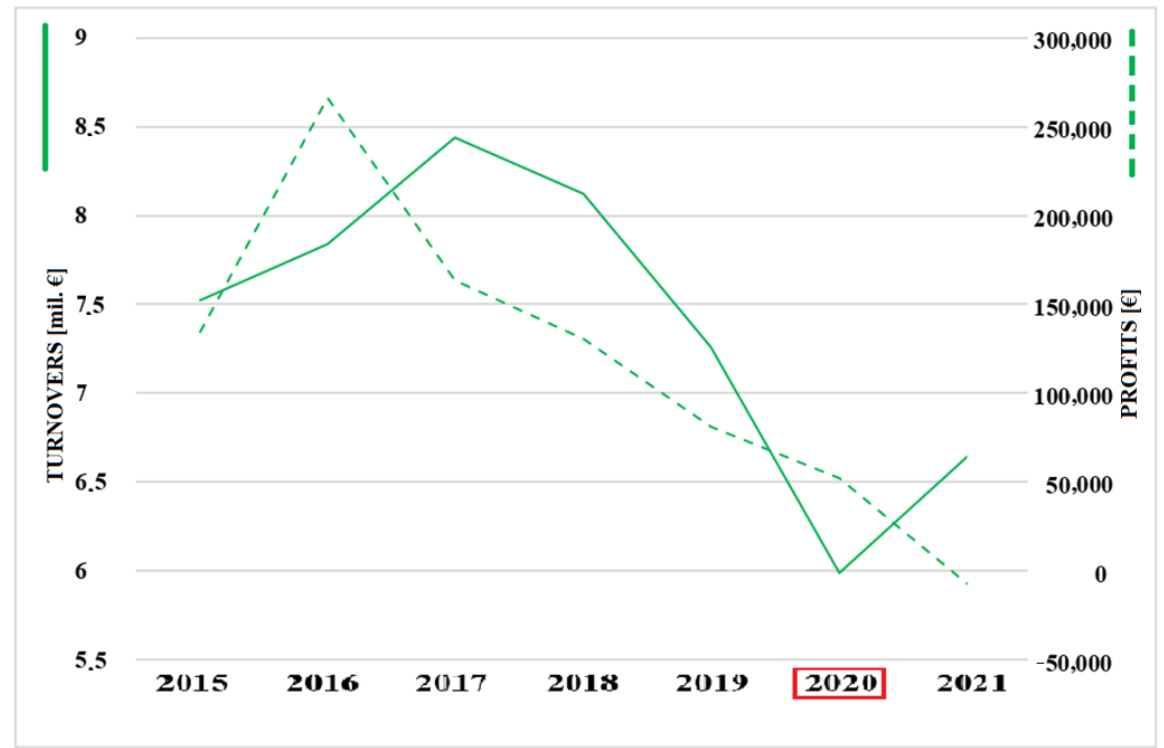
Figure 2. Development of profits and turnovers of Company V from 2015 to 2021 [56].